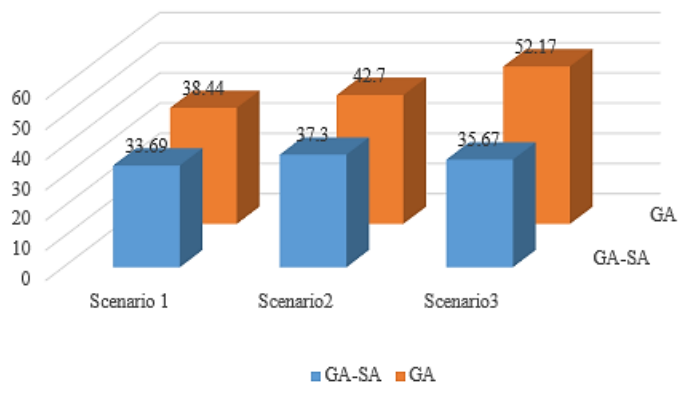
Fig. 17. Comparison of the different algorithms in term of average ObjFun over 10 runs.